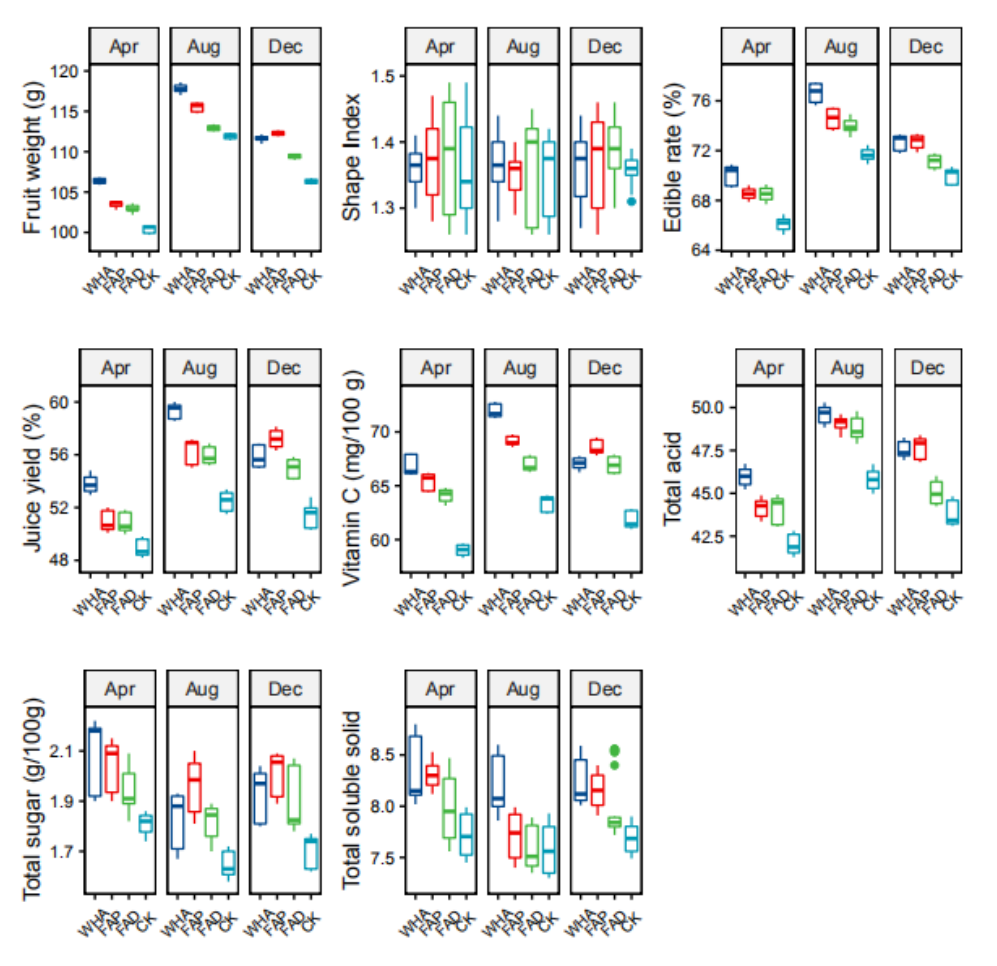
Figure 2. Analysis of effects of humic/fulvic acid fertilizer on quality of lemon fruit presented by boxplot.